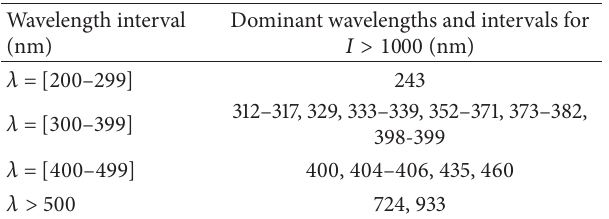
Table 3: Dominant wavelengths present in light emission of value 𝐼 > 1000 . Wavelength